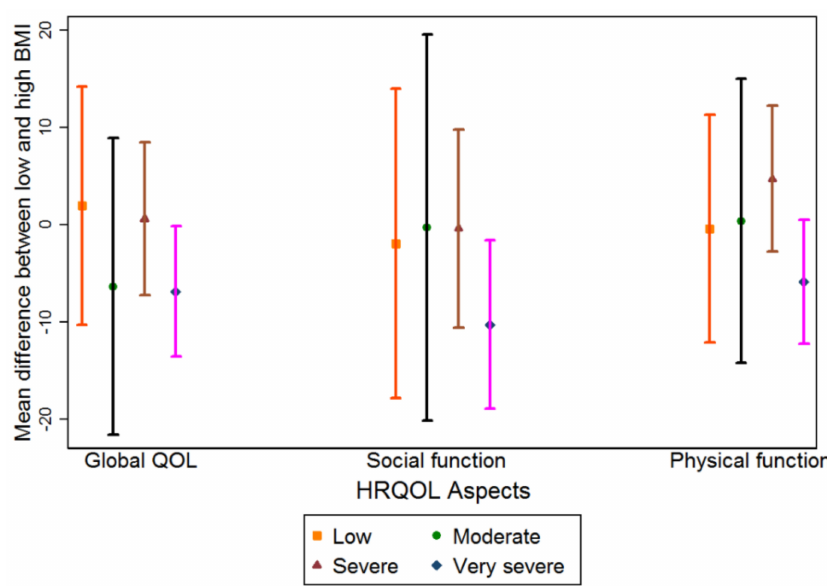
Figure 2. Chart showing mean score differences with 95% CI for global QOL, social and physical function among those with ‘low’, ‘moderate’, ‘severe’ and ‘very severe’ nutritional problems comparing low and high preoperative BMI groups. BMI—Body mass index; QOL—Quality of life; HRQOL—Health related quality of life; NIS—Nutrition impact symptoms; WL—Weight loss; CI—Confidence interval.